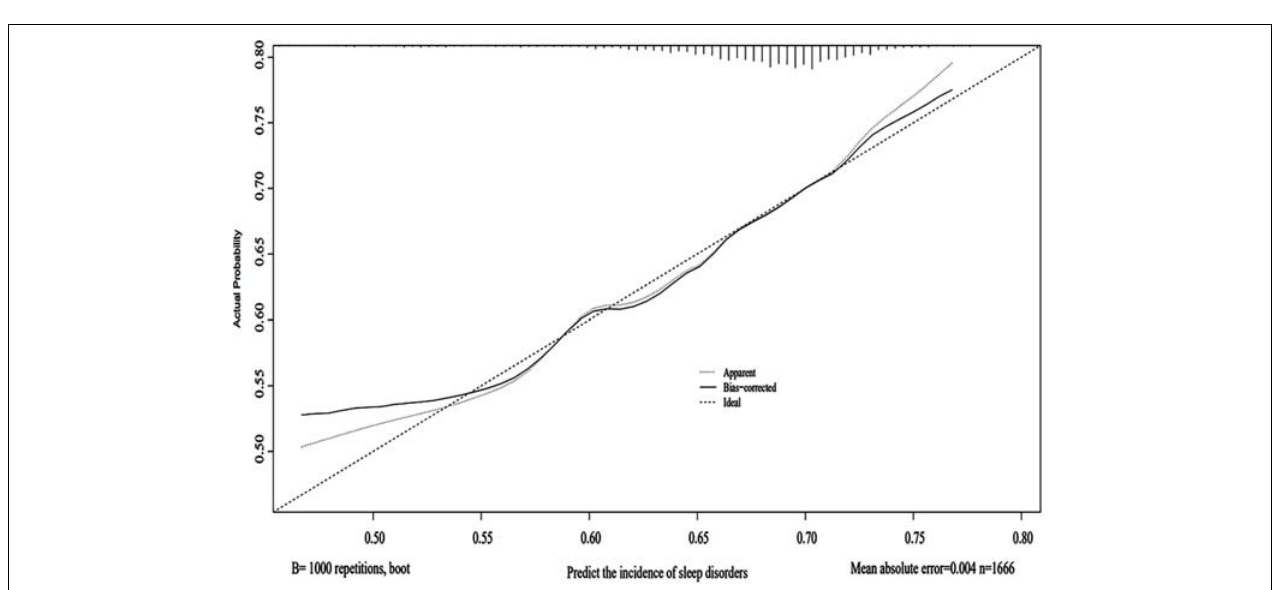
FIGURE 3 | Calibration of the nomogram. The predictive performance for the incidence of sleep disorders was evaluated in the validation set, which was applied with the 1000 bootstrap resampling. The predicted probability and the observed probability are presented by the X and Y axes, respectively.